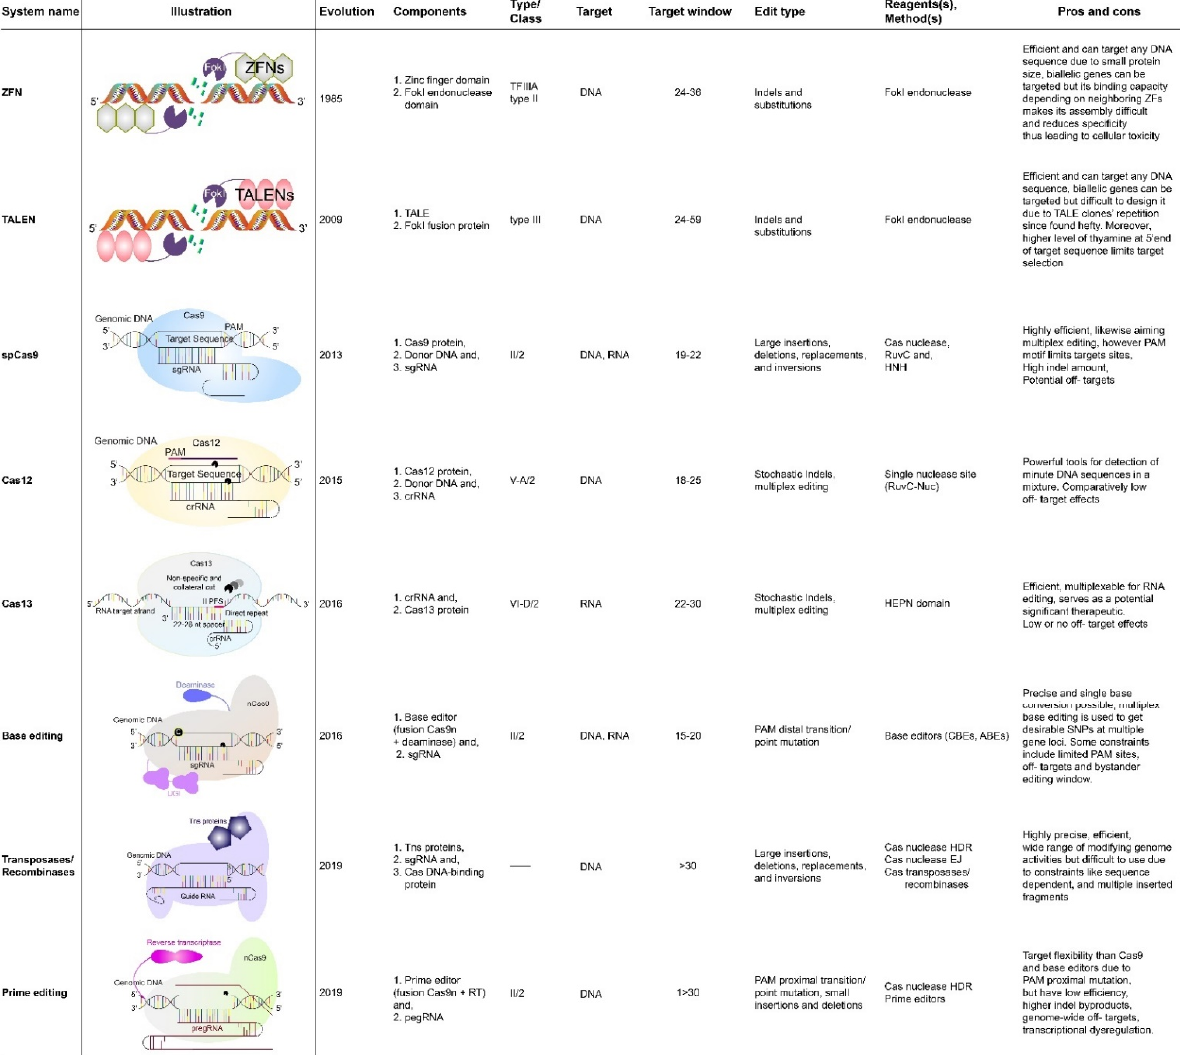
Figure 2. Comparison between different components of various genome-editing tools. The figure presents the models of different genome editing systems, such as ZFN (zinc-finger nucleases), TALEN (transcription activator-like effector nucleases), spCas9 (streptococcus pyogenes CRISPR-associated protein 9), Cas12, Cas13, Base editing, Transposases or recombinases, and prime editing, their evolution, components, class or type of editing system, target nucleic acid, length of target sequence, type of mutations, reagents and methods, and their advantages and disadvantages. PAM, protospacer adjacent motif; sgRNA, single guide RNA; crRNA, CRISPR RNA; Tns Proteins, Transposases proteins; pegRNA, prime editing guide RNA; RT, Reverse Transcription; DNA, Deoxyribonucleic acid; RNA, Ribonucleic acid; RuvC, an endonuclease domain named for an Escherichia coli protein involved in DNA repair; HNH, an endonuclease domain named for characteristic histidine and asparagine residues; HDR, homology-directed repair; indel, insertion and/or deletion; CBEs, cytosine base editors; ABEs, adenine base editors.